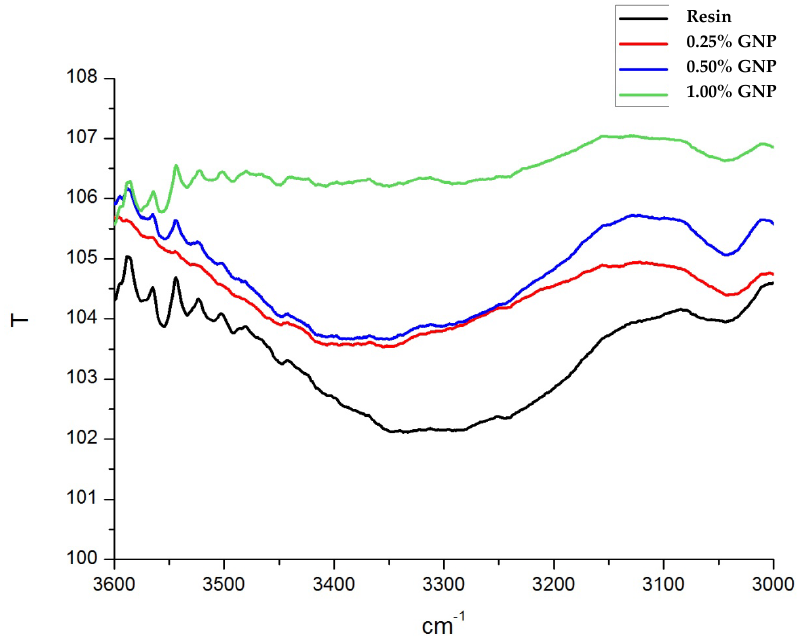
Figure 18. Comparison of IR signals of water stretching in resin at 1000 rpm in composites after 31 days of